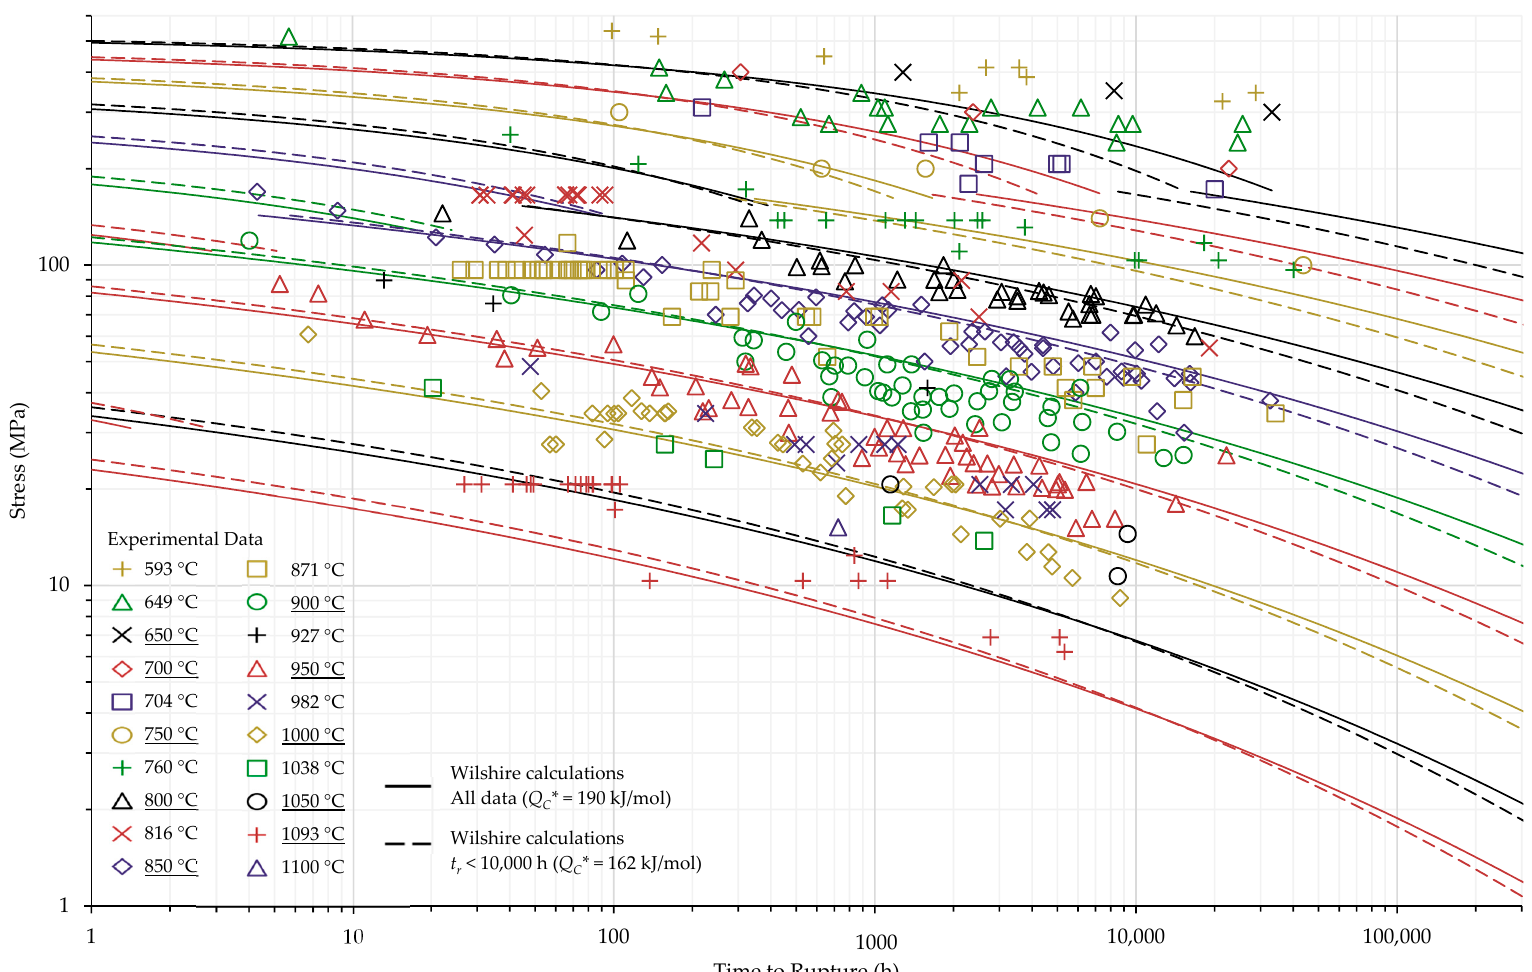
Figure A9. Split region calculations of the Wilshire equation with Q ∗ determined using Arrhenius plots for Inconel 617 shown at underlined temperatures.